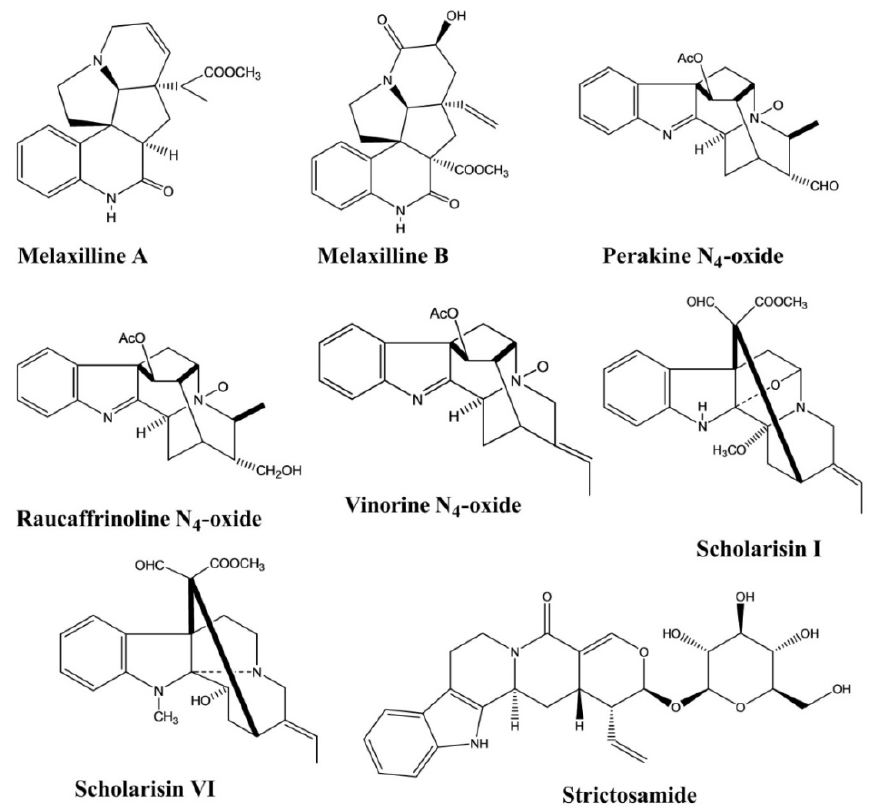
Figure 6. Anti-inflammatory activity of indole alkaloids.